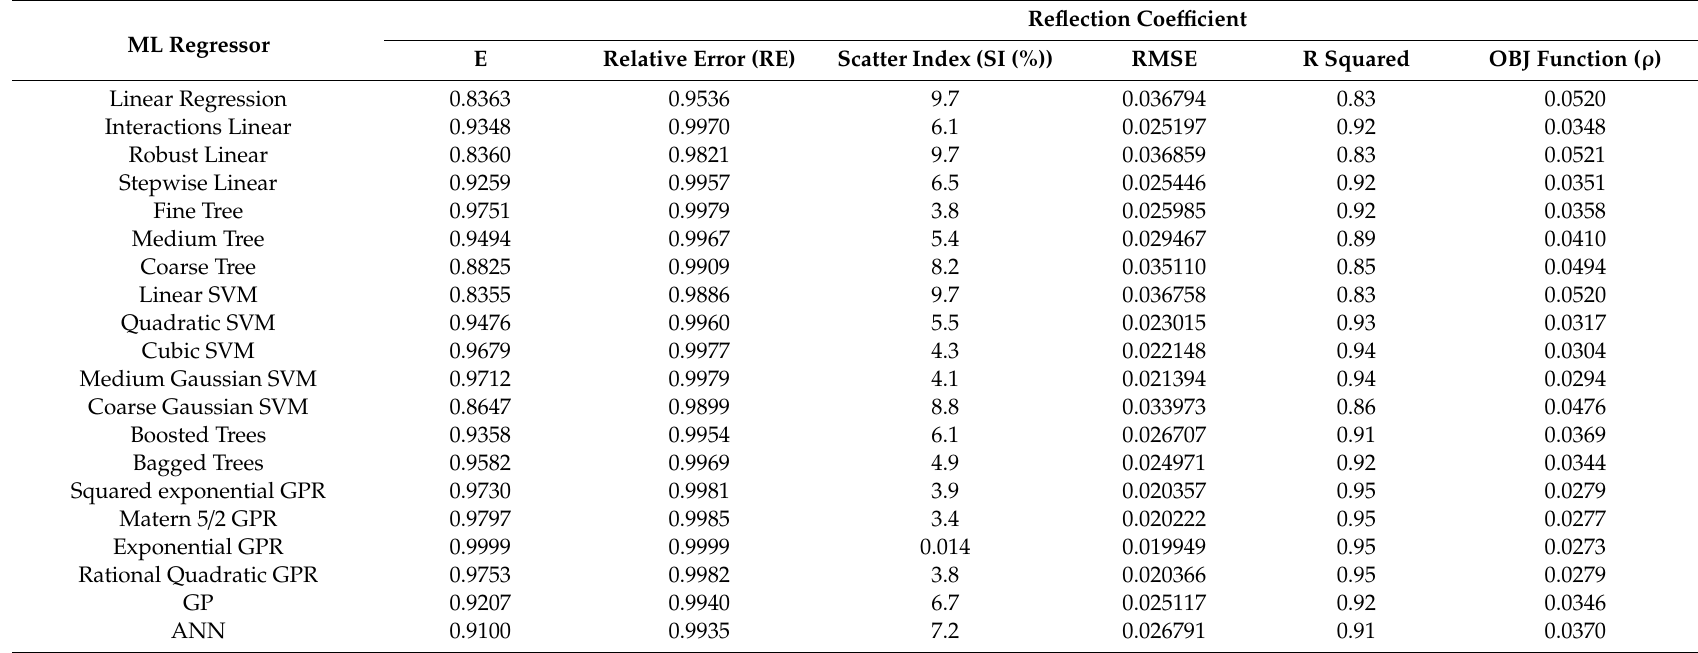
Table 3. Proposed ML regressors and their result for the reflection coe ffi